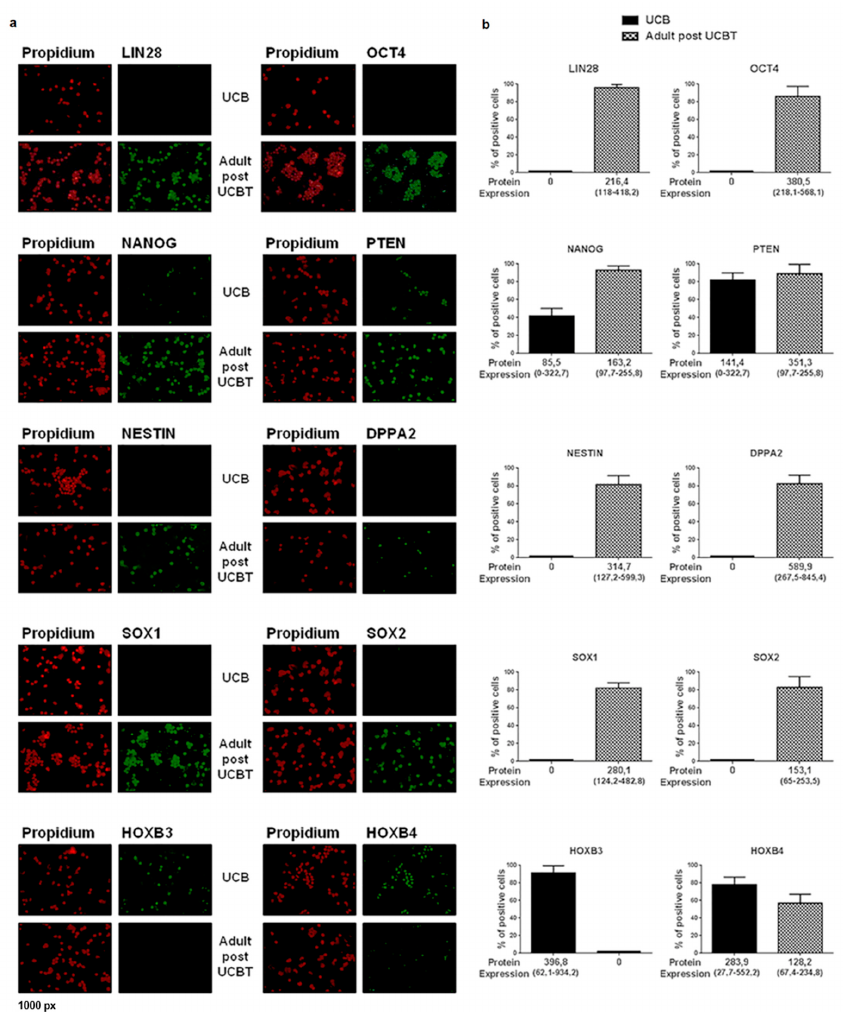
Figure 3. Panel a : Immunofluorescence using specific antibody (green signal) for the proteins indicated in top of the picture. Nuclei are marked in red. For each protein evaluated, the upper panels are referred to CD34+ cells isolated from UCB and the lower panels are referred to CD34+ cells isolated after UCBT. Panel b : For each protein indicated in top of the picture, the black column represents the percentage of CD34+ from UCB positive for the selected protein and the grey column the percentage of positive CD34+ from adult patients after UCBT. The mean value of protein expression in single cells and the range are indicated below the columns. Results showed that the number of cells expressing proteins is always higher in adults after UCBT compared to UCB. Nevertheless, the level of protein in single cells is always significantly lower in UCB (see median values and ranges reported under each graph).